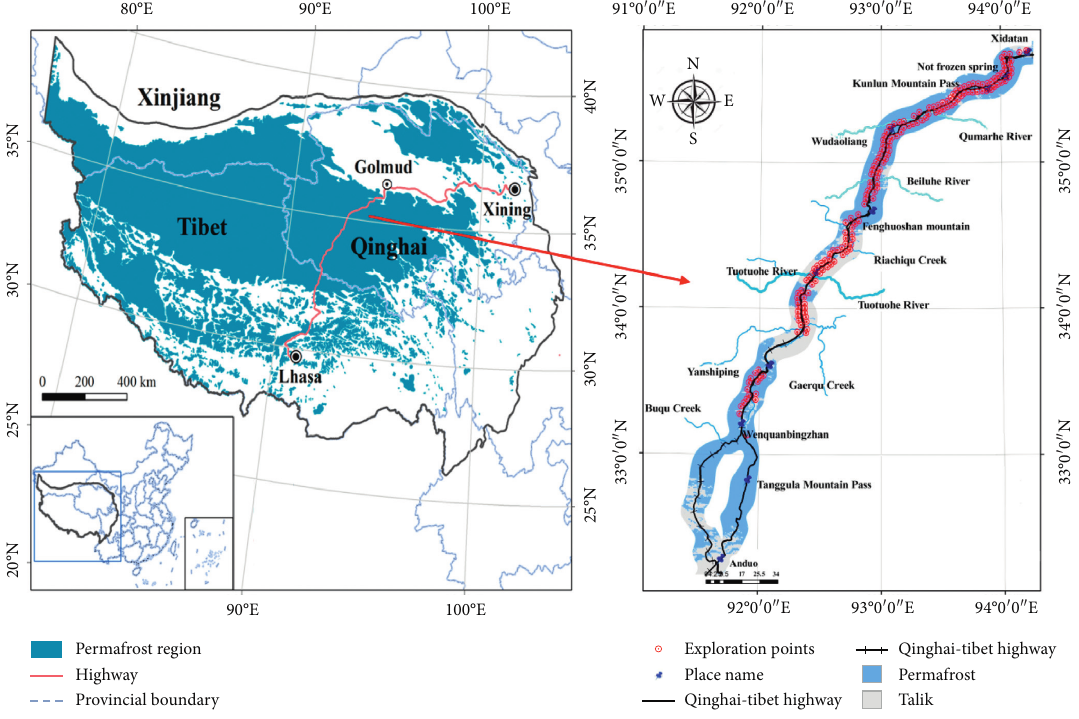
Figure 1: Schematic of the sampling spot along the QTEC [16].